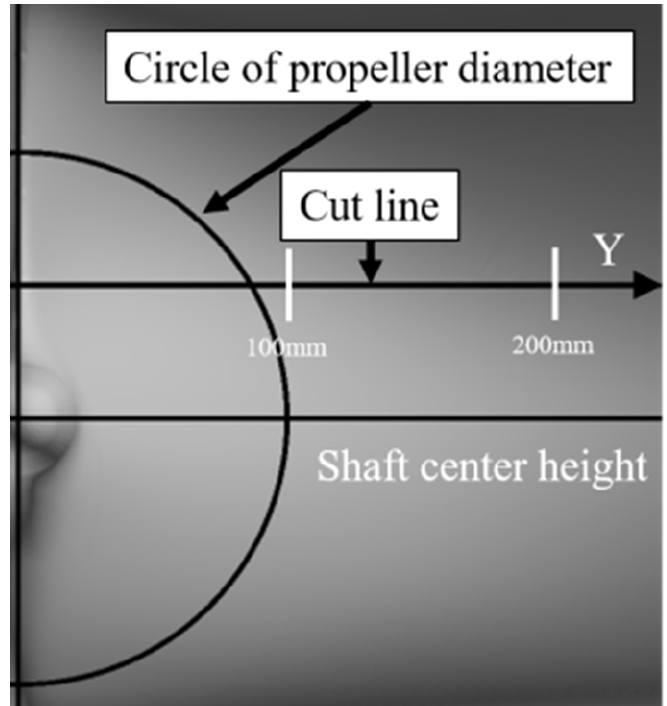
Figure 9. Schematic view of a cut line.